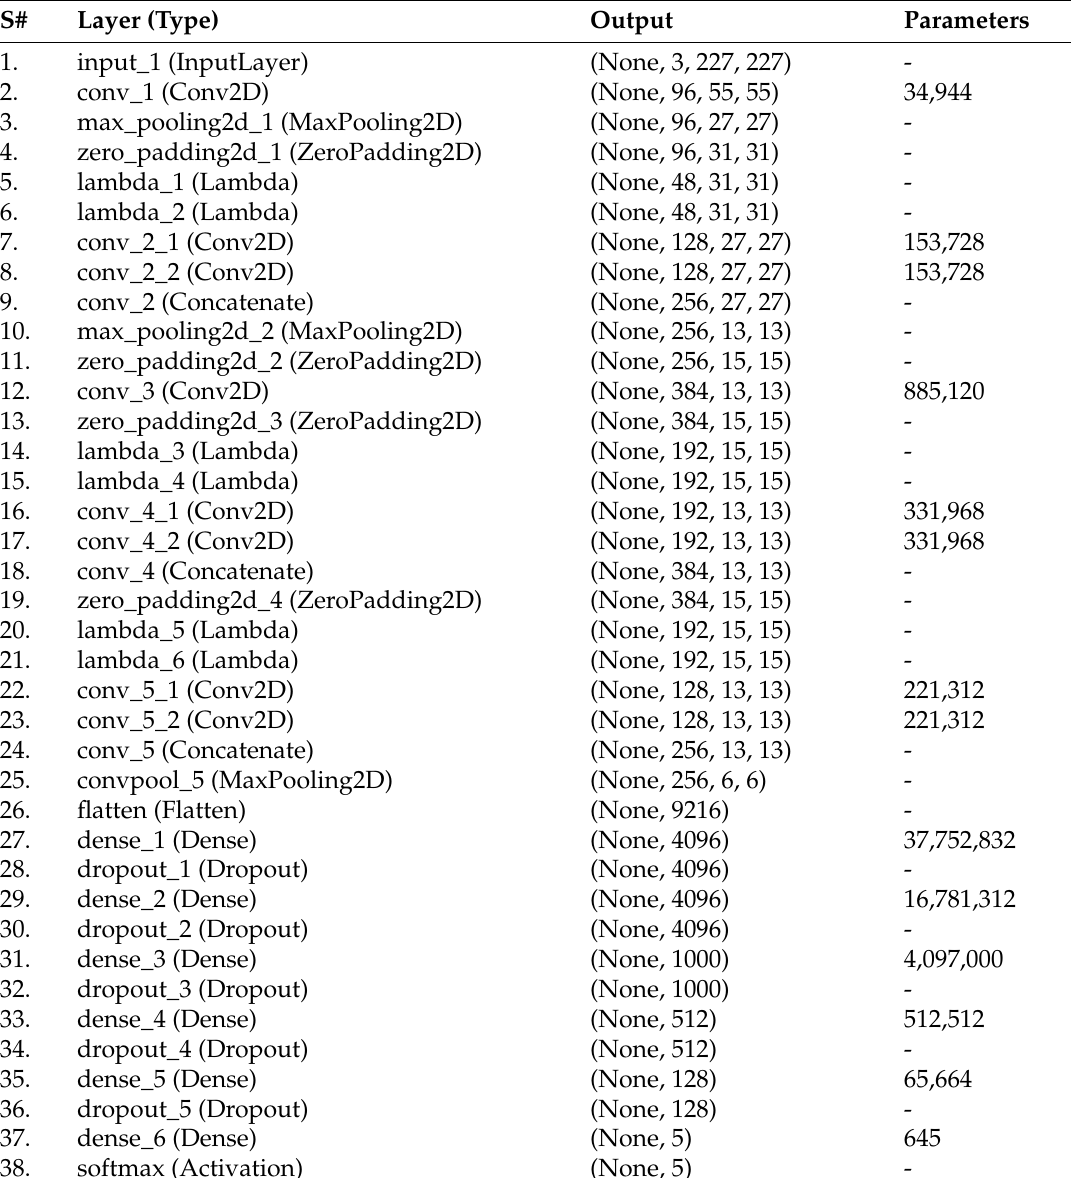
Table 1. Proposed model architecture (Transfer